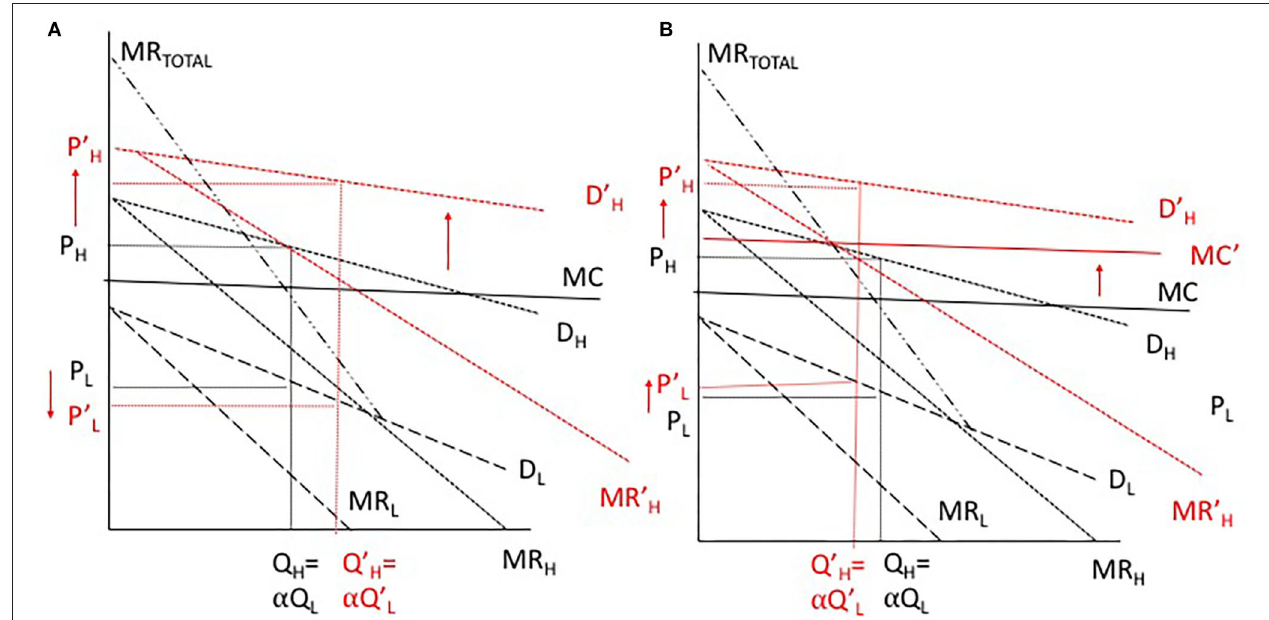
FIGURE 4 | Pricing of joint products under monopoly pricing under scenarios of increased demand (A) and increased demand and marginal cost (B) . Adapted from